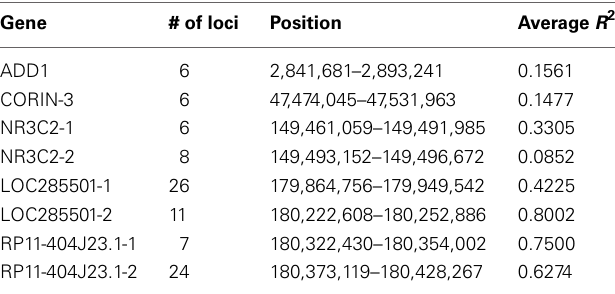
Table 1 | Summary of the selected haplotype